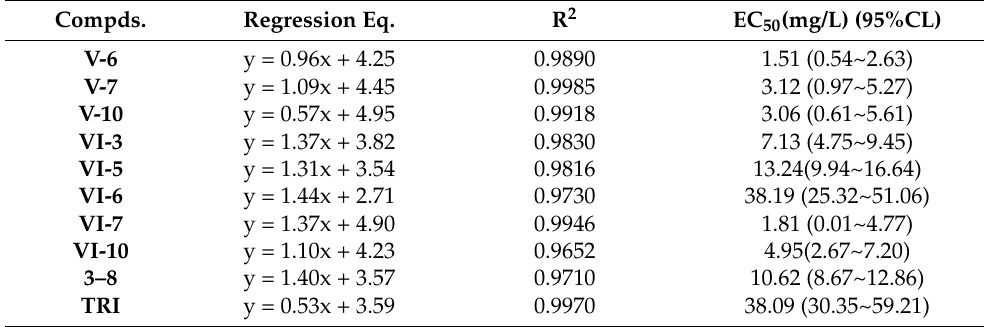
Table 2. The EC 50 values of compounds V - 6 , V - 7 , V - 10 , VI - 3 , VI - 5 , VI - 6 , VI - 7 and VI - 10 on S. sclerotiorum